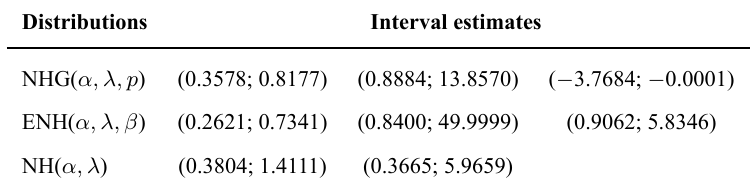
Interval estimates by double percentile bootstrap for the model parameters at a confidence level of 95 %